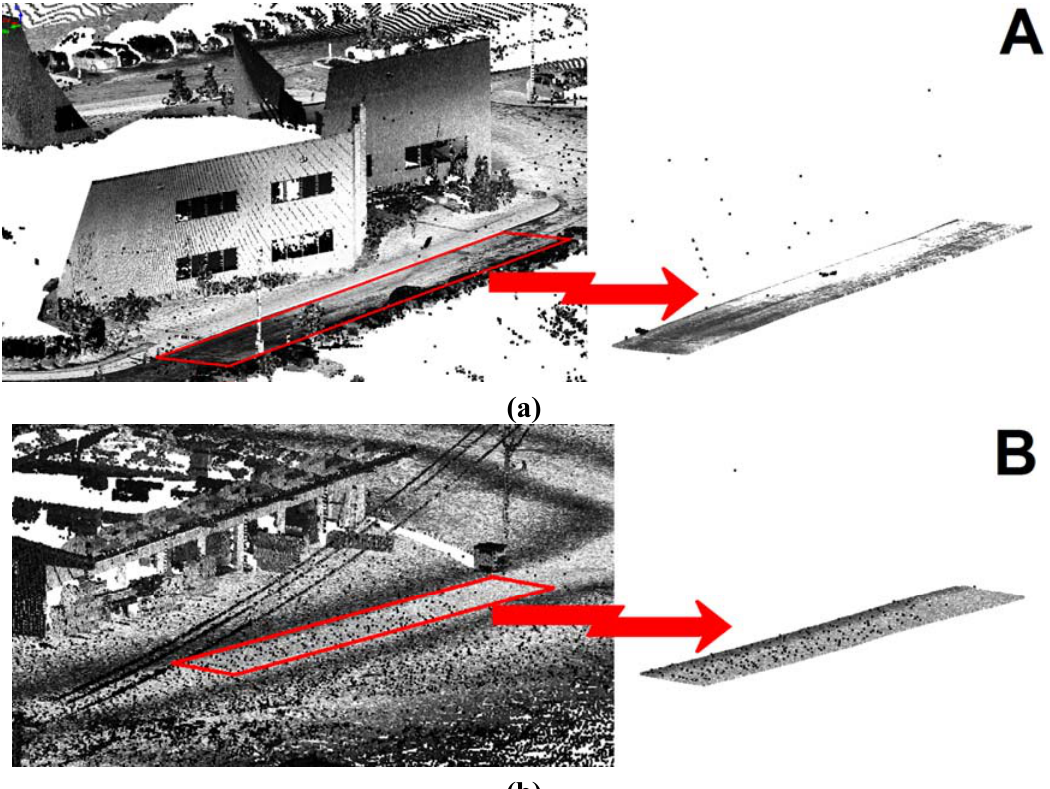
Figure 6. Point clouds of simple geometry taken from two separate parking lots